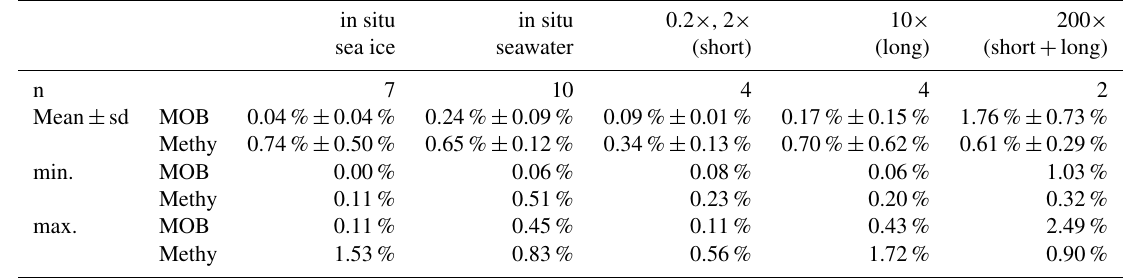
Table 4. Relative abundance of methylotroph OTUs in situ, split into methanotrophs (MOB) and non-MOB methylotrophs (Methy) in situ in situ